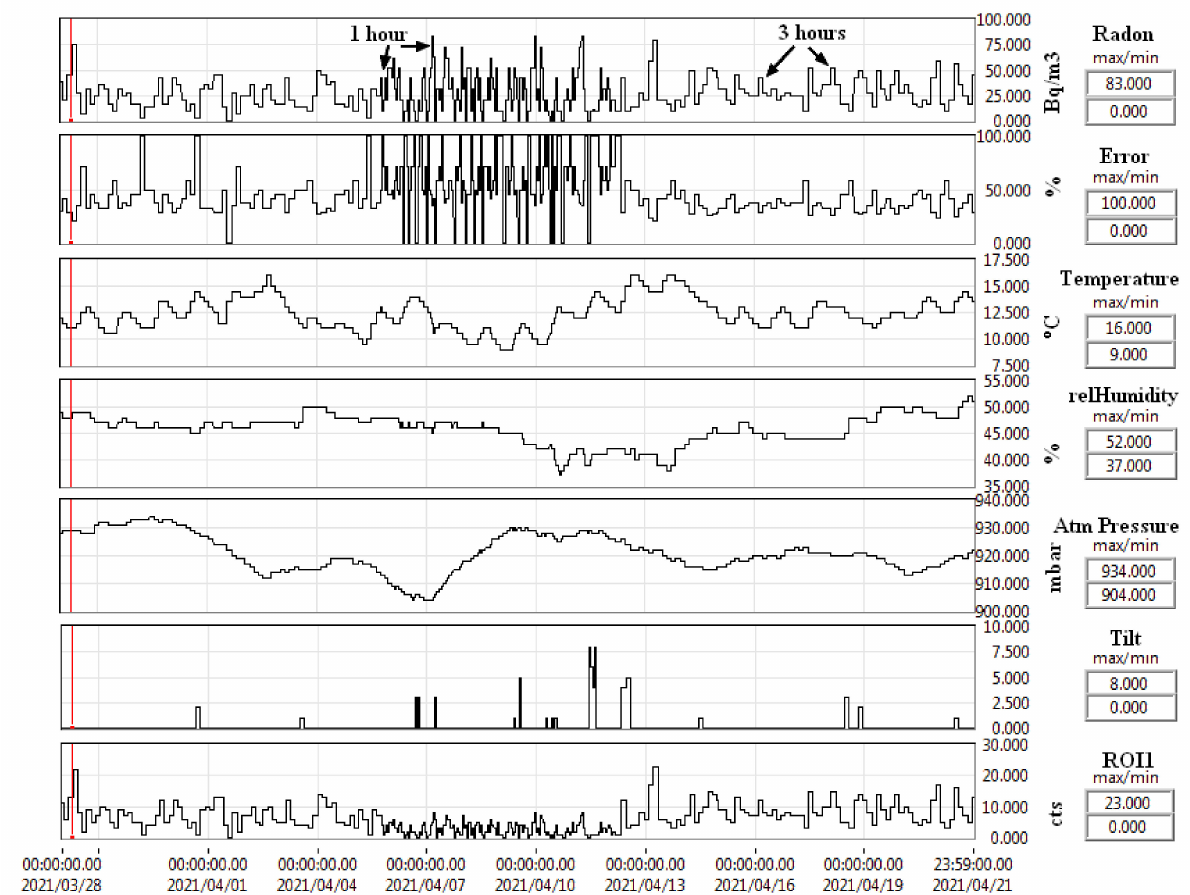
Figure 7. Dependence of sampling rate measurement error, Radon Scout Plus